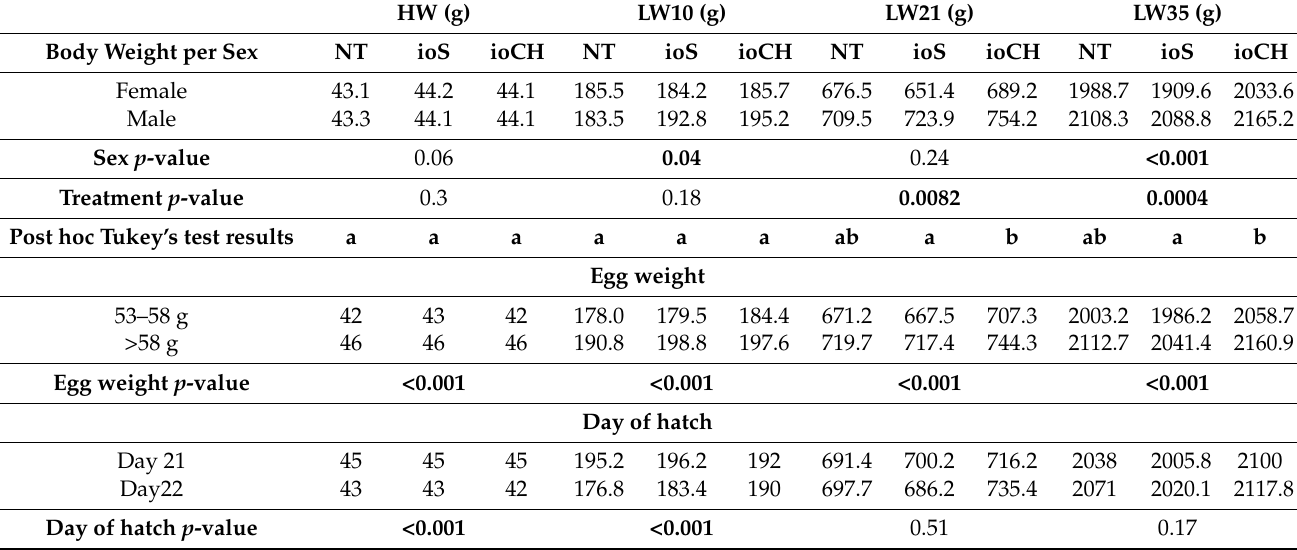
Table 4. Effects of in ovo treatments, sex, egg weight, and the day of hatch on live weight. HW